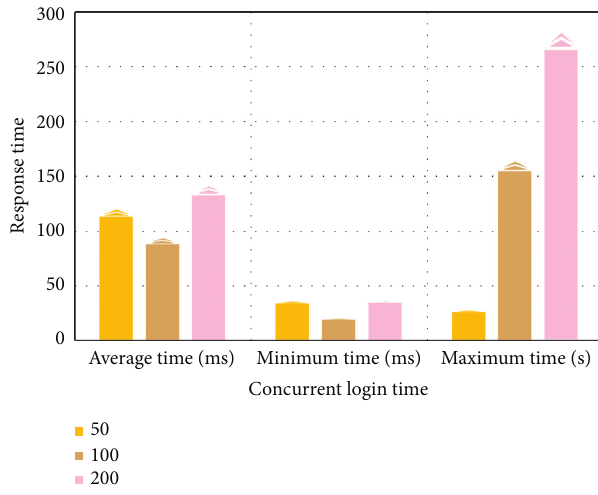
Figure 4: Concurrent login response